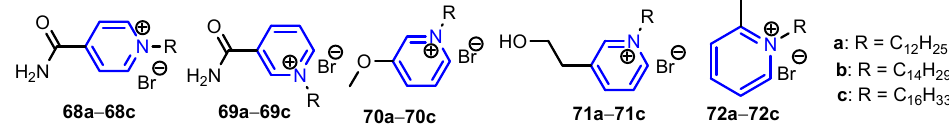
methylamino)pyridinepropylthioacetate 73 (Scheme 12) and effects of 73 coated with gold nanoparticles 73 -AuNPs against E. coli (ATCC 8739). The MIC of the Pefloxacin + 73 - AuNPs mixture was found to be 25 µ g mL − 1 as compared to Pefloxacin alone (50 µ g mL − 1 ), which clearly indicates that 73 -AuNPs increased the potency of Pefloxacin.